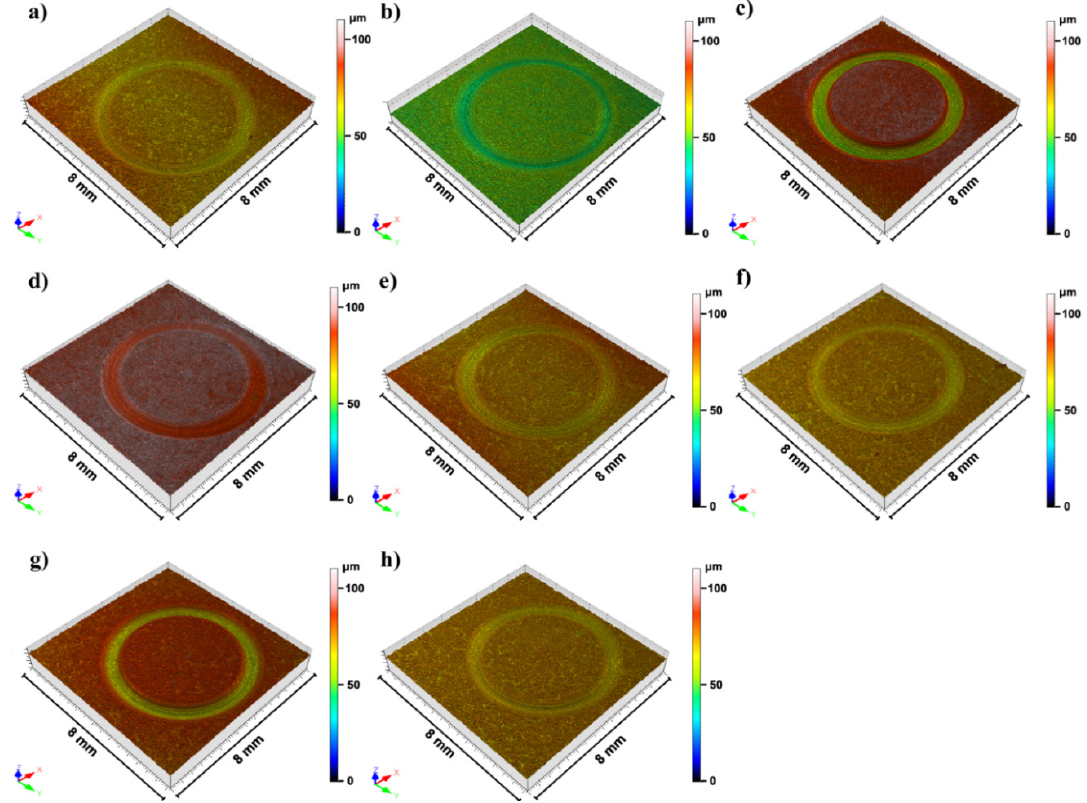
Figure 6. Confocal microscopy images of 3D wear tracks of coatings obtained from experiments 1–8 ( a – h ) and subject to wear tests. Table 4. Summary of the values of the properties of the NiP coatings obtained from the eight experiment setups. L